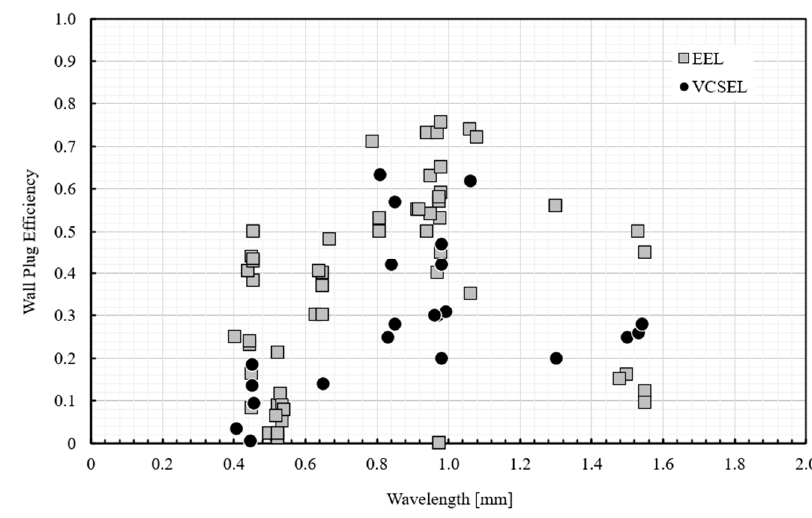
Figure 13. E ffi ciency dependence on wavelength (courtesy of T. Miyamoto). Figure 13. Efficiency dependence on wavelength (courtesy of T.